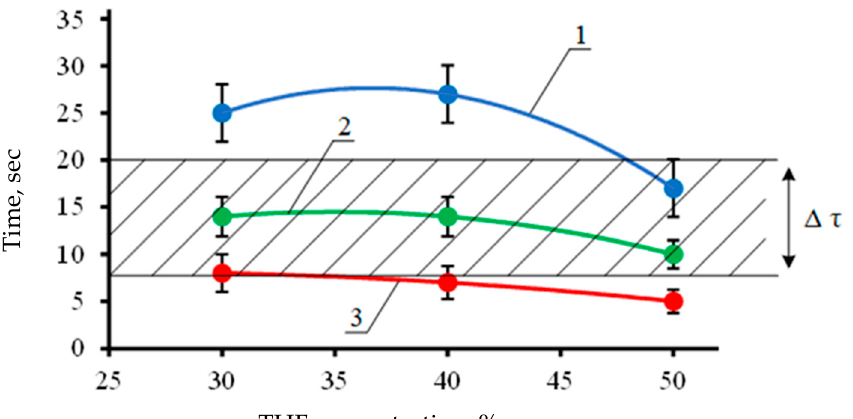
Figure 8. Swelling time to maximum absorption versus the THF solution concentration. 1–22 ± 1 °C, 2–36 ± 1 °C, 3–65 ± 1 °C. Δτ is the time interval of contact between the liquid and the film.